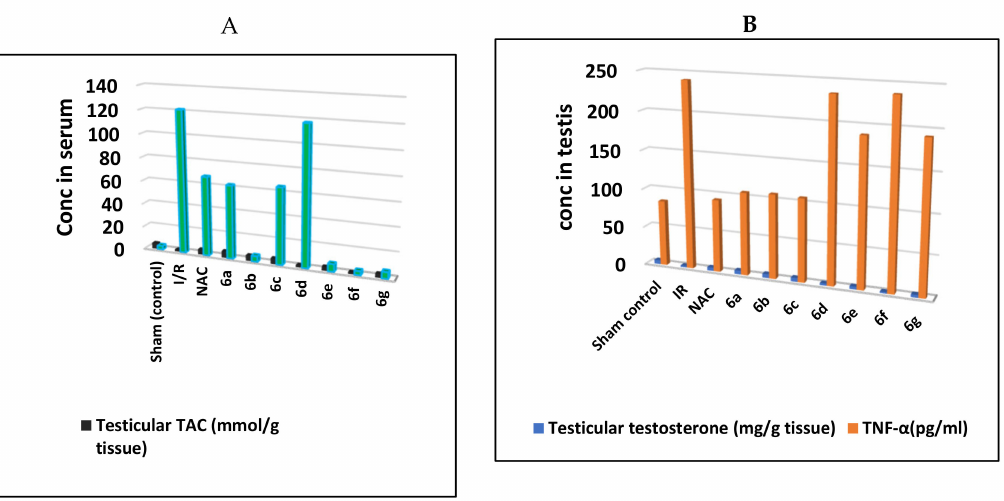
Figure 6. Concentrations of ( A ); testicular malondialdehyde (MDA) and testicular total antioxidant capacity (TAC), ( B ); testicular testosterone and TNF α in the testis of I / R rats treated with compounds 6a – g and